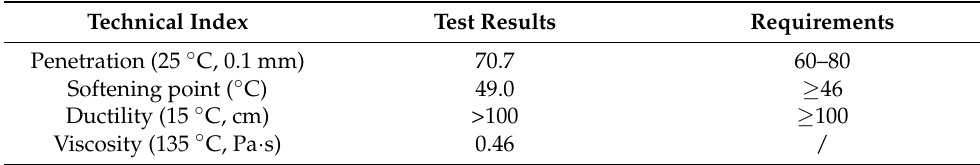
Table 2. Mechanical properties of